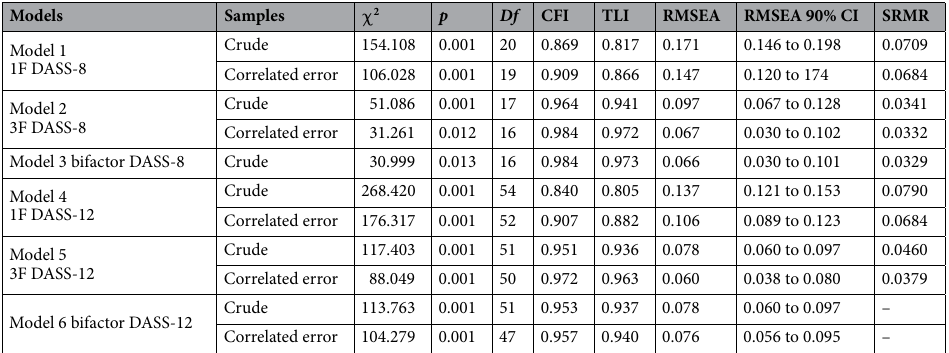
Table 2. Goodness-of-fit of the confirmatory factor analysis models representing the Depression Anxiety Stress Scale-8 (DASS-8) and the DASS-12 in the whole sample. χ 2 , chi-square; df, degrees of freedom; CFI, comparative fit index; TLI, Tucker–Lewis index; RMSEA, root mean square error of approximation; CI, confidence interval; SRMR, standardized root mean residual; –, SRMR was not produced denoting improper convergence of the